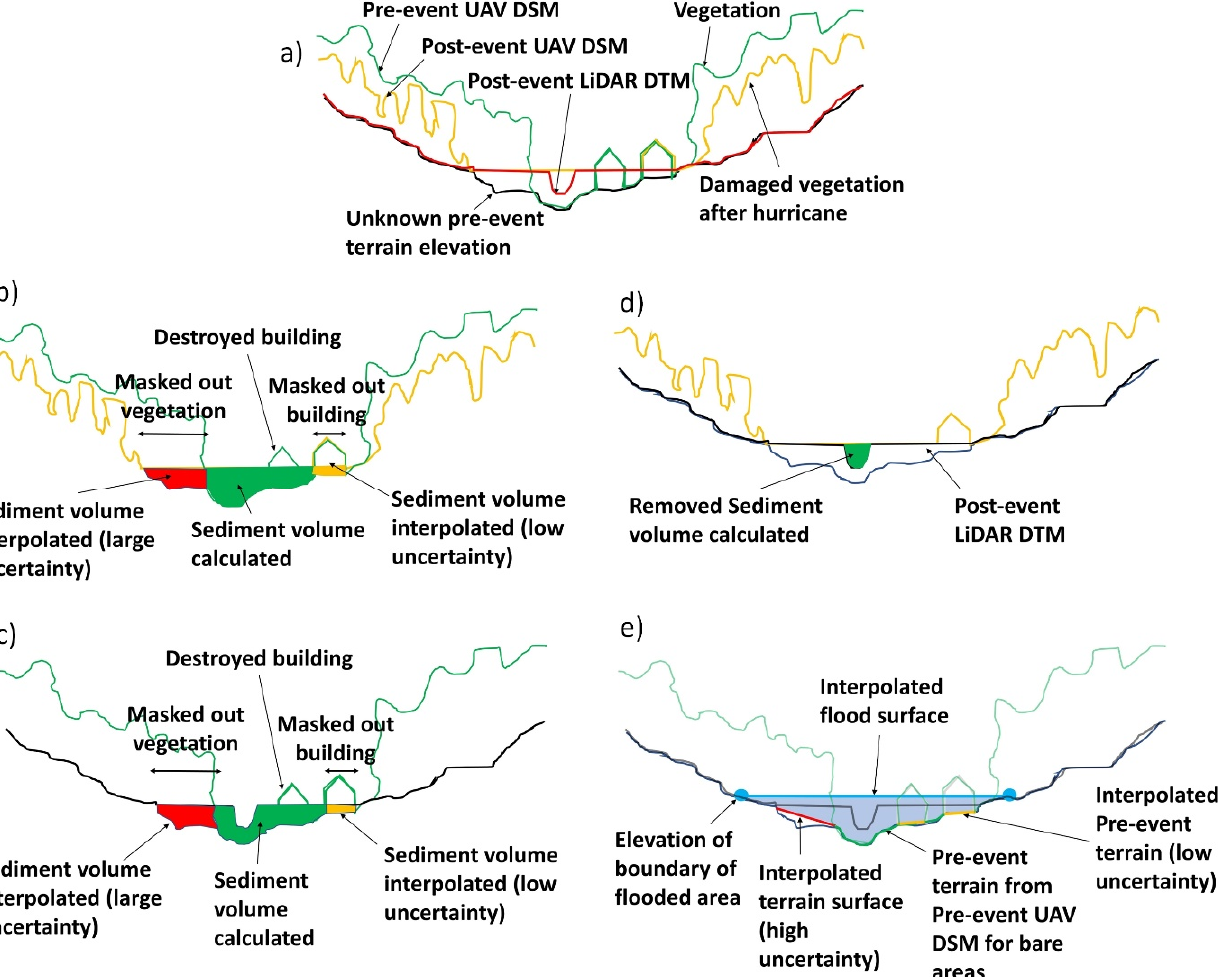
Figure 6. Illustration of the methods applied for estimation of sedimentation volumes from pre-event UAV DSM, and post-event UAV DSM and LiDAR DTM. ( a ) Cross section of a valley with vegetation and buildings showing the elevation of the various elevation data sources, and the unknown pre-event topography. ( b ) Calculation of sediment volume from pre-event UAV DSM and post-event UAV DSM, using a method to interpolated thicknesses in areas occupied by vegetation or buildings. ( c ) Calculation of sediment volume from pre-event UAV DSM and post-event LiDAR DTM, using a method to interpolated thicknesses in areas occupied by vegetation or buildings. ( d ) Calculation of the removed sediments from the difference between the post-event LiDAR DTM and post-event UAV DEM. ( e ) Calculation of the maximum flood level, by establishing the elevation of the sides of the affected area on the LiDAR DTM following by trend surface interpolation, and reconstruction of the pre-event topography from the pre-event UAV DSM and interpolation in masked areas of vegetation and